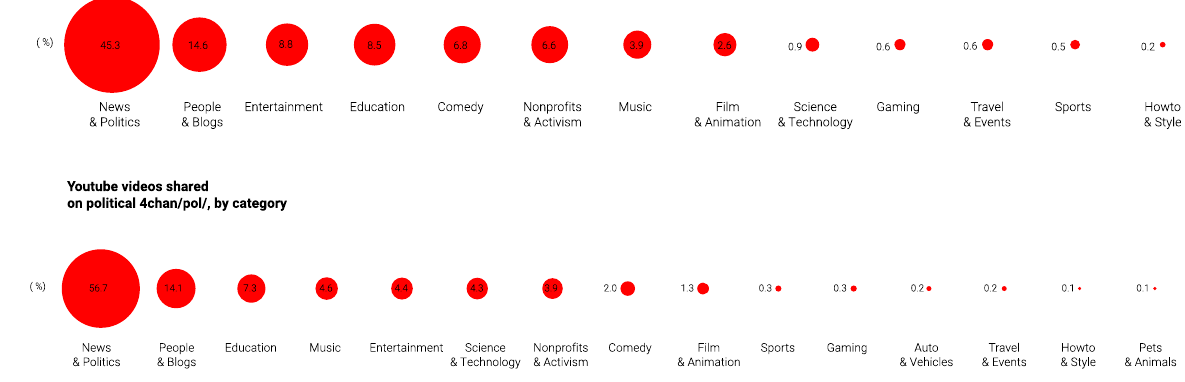
Figure 3. Categories of YouTube videos shared on 4chan /pol/ and political Reddit. Retrieved 21 April 2020; data source: